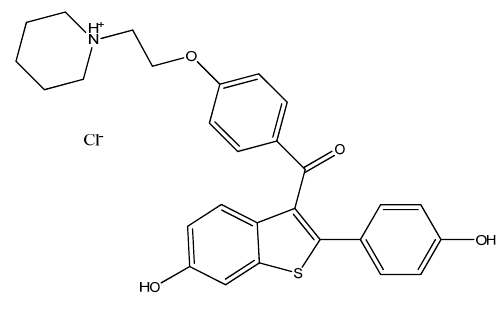
Figure 1. Chemical structure of Raloxifene